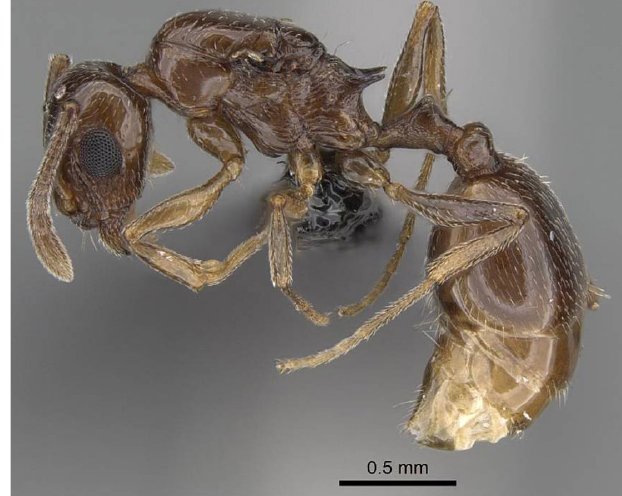
Fig 5 . Temnothorax ansei sp.n. queen in lateral view. Photo credit: